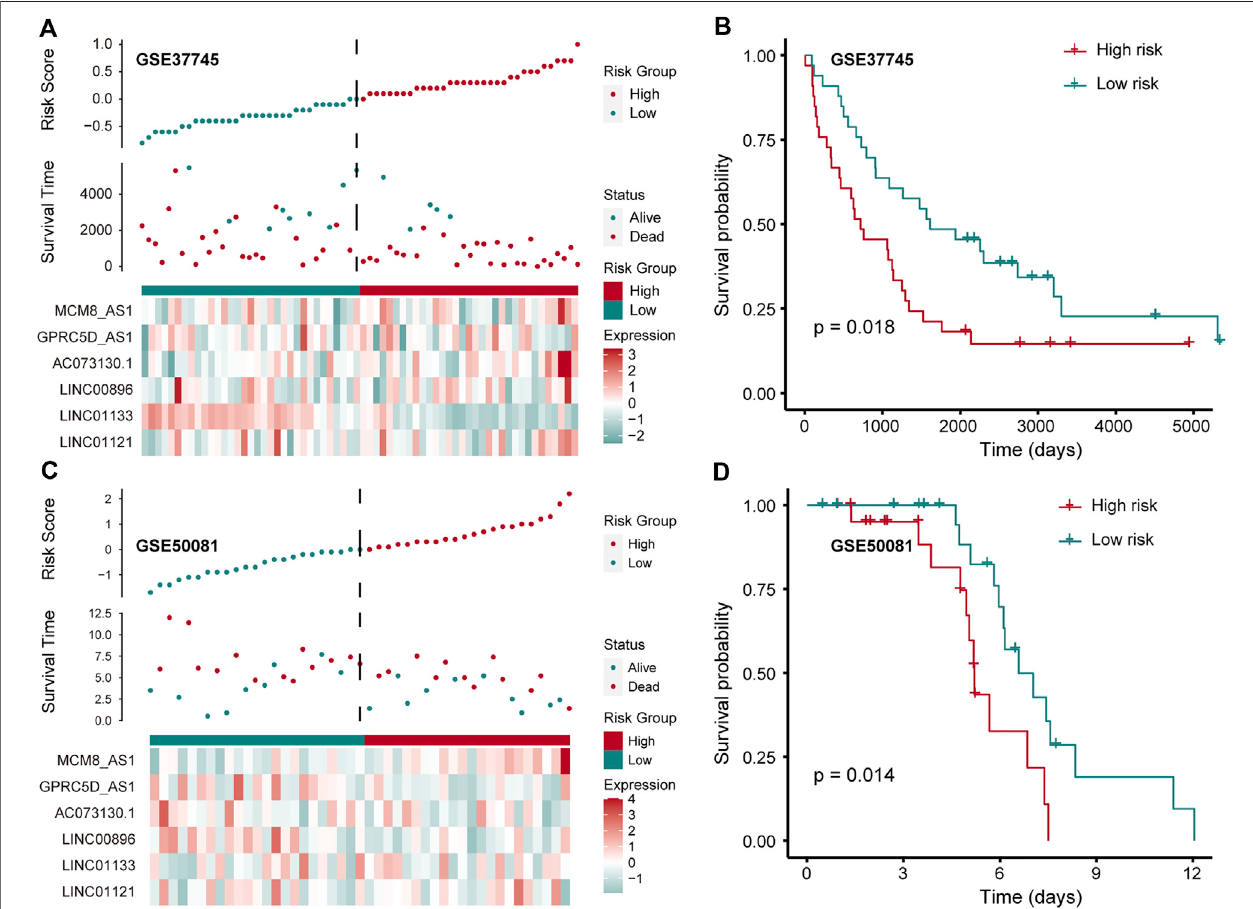
FIGURE 4 | Veri fi cation of prognostic markers in public data. (A) The expression pattern of lncRNA and survival status and risk scores of LUSC patients for GSE37745series. (B) Kaplan – Meiercurveoftwogroups(high-/low-riskscore)forGSE37745series.Log-ranktestisusedtocalculatestatisticalsigni fi cance.Theunitof timeisdays. (C) Thesameasin (A) butforGSE50081series. (D) Kaplan – Meiercurve oftwogroups (high-/low-riskscore)forGSE50081series.Theunit oftime isdays.